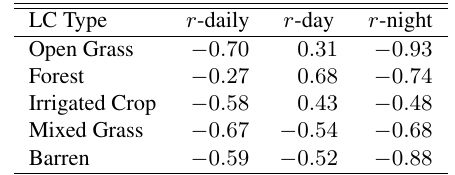
Table 3: Pearson’s r values from correlation of in-situ surface temperature vs. in-situ SM based on data from 21 st of Nov. 2011 over various LC